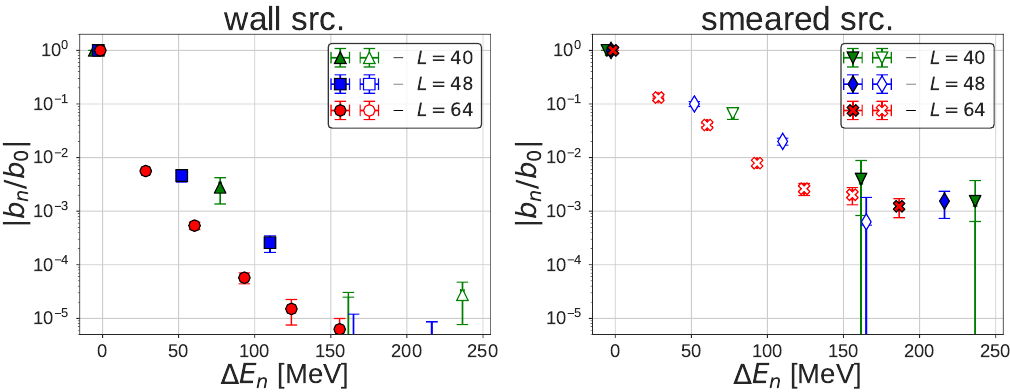
Figure 9 . The ratio of the overlap coe(cid:14)cients in the temporal correlation function j b n =b 0 j obtained at t=a = 13 for the wall source (left) and the smeared source (right) on various volumes. Solid (open) symbols correspond to positive (negative) values of b n =b 0 .